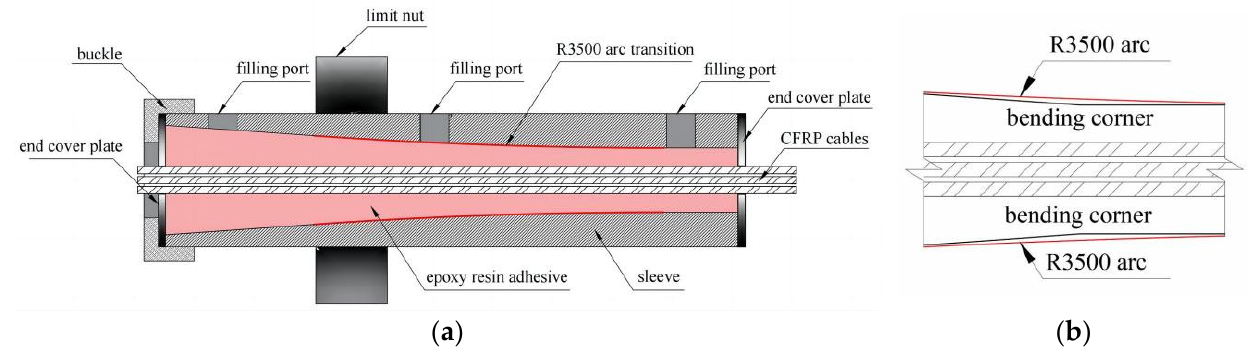
Figure 1. Section drawing of inner cone + arc + straight cylinder bond-type anchorage: ( a ) vertical section drawing of the anchorage; ( b ) comparison of the new anchorage’s transition section with the inner cone + straight cylinder anchorage.